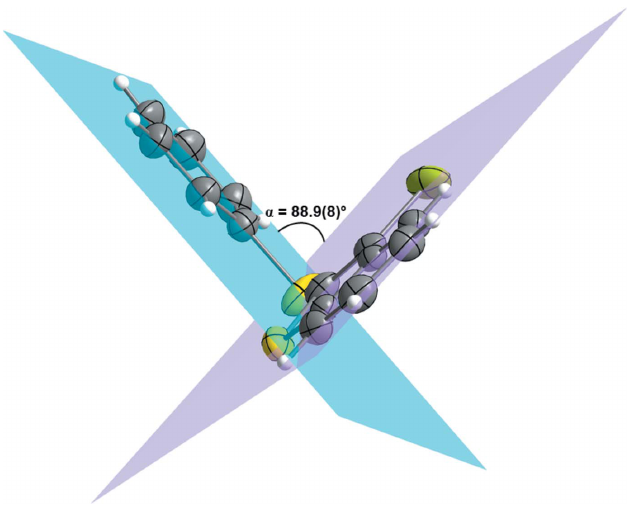
Figure 5 Representation of the interplanar angle ( (cid:4) ) between the planes containing the phenylsulfanyl, blue plane, and the benzo[ b ]thiophene, purple plane, groups for 3-bromo-2-(phenylsulfanyl)benzo[ b ]thiophene ( 1 ). Displacement ellipsoids are drawn at the 50% probability level. Gray: carbon; yellow: sulfur; light green: bromine; white: hydrogen. angles of 80.4 (8) and 79.7 (7) (cid:3) , respectively (Figs. 7 and 8). Conversely, the torsion angles (Se1—C2—Se10—C11) in molecules 3 and 4 are 1.9 (3) and (cid:4) 4.0 (3) (cid:3) , respectively, quite